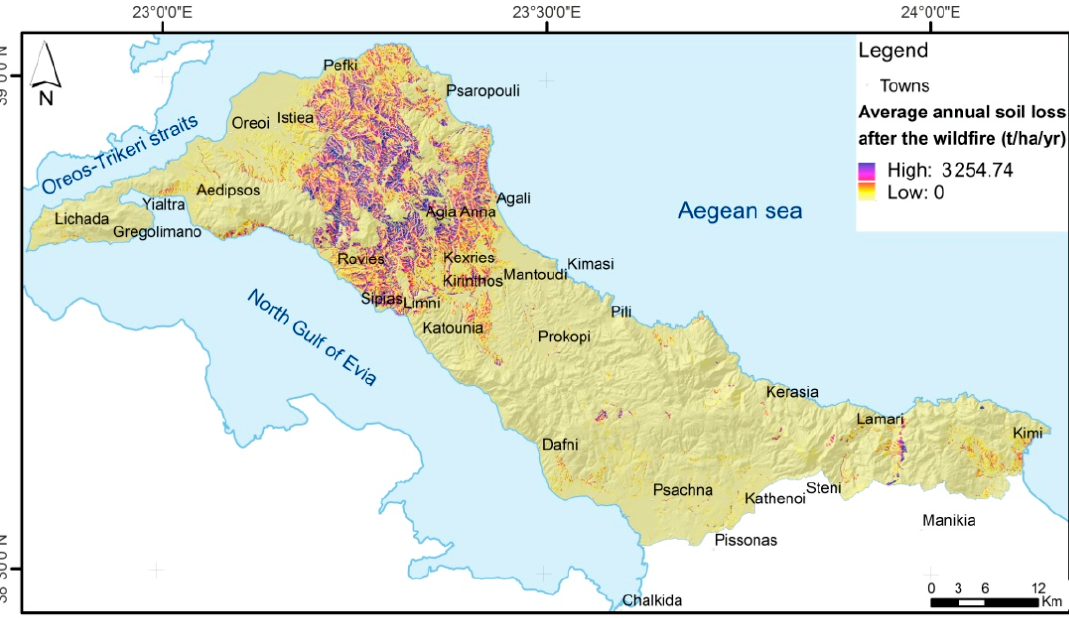
Figure 4. Spatial distribution map of the annual soil loss potential under the natural (pre-fire) condition.